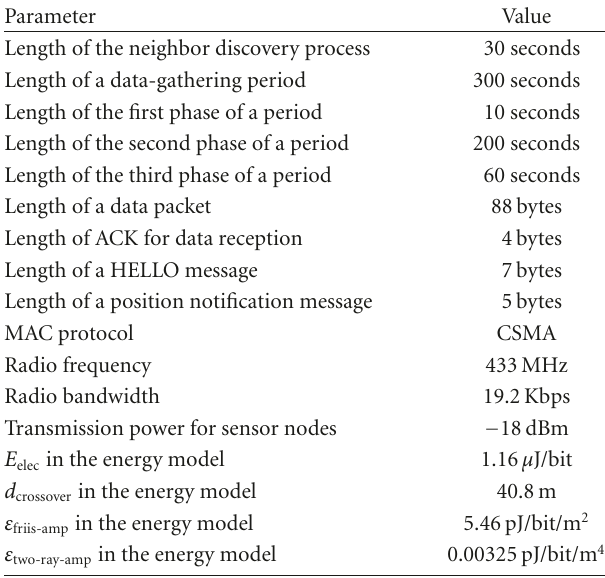
Table 1: Main simulation